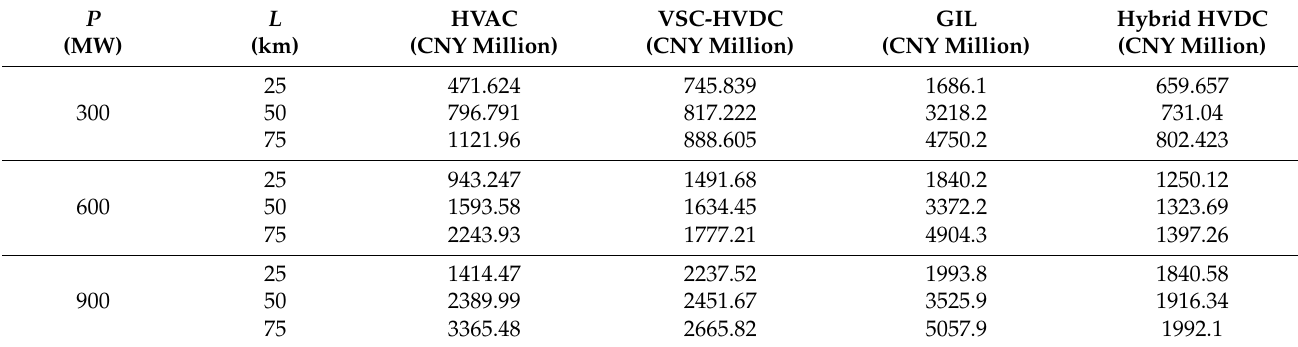
Table 3. Economic costs comparisons of different P and different L .